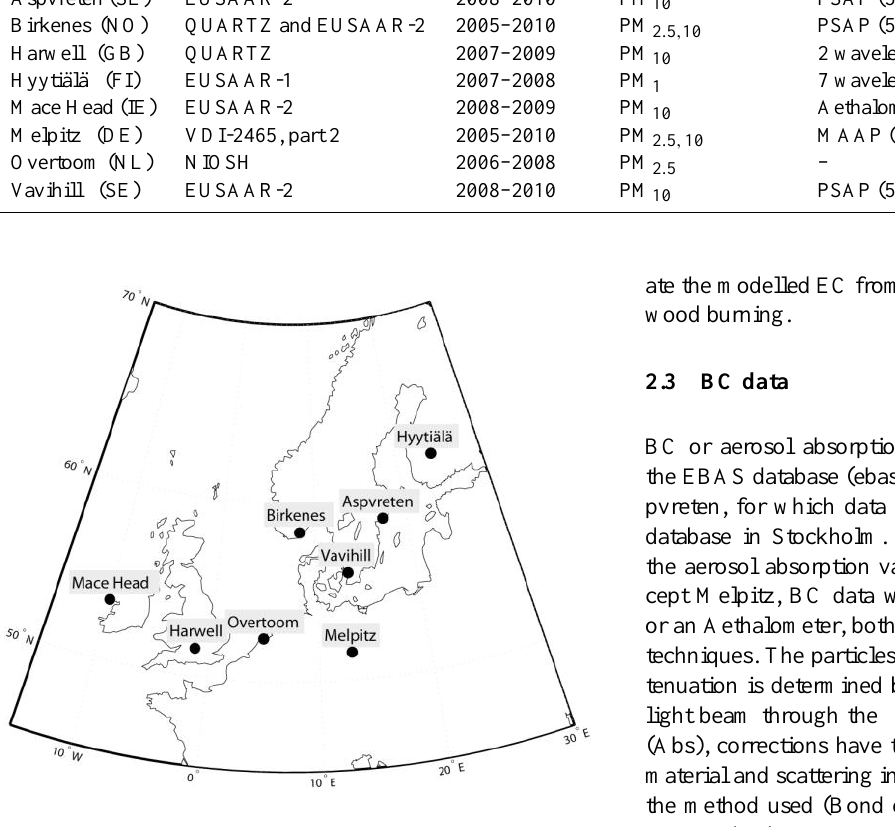
Fig. 1. Map of north-western and central Europe and the locations Fig. 1. Map of North-western and Central Europe and the locations of the eight stations used in 2 of the eight stations used in the present the present study. 3